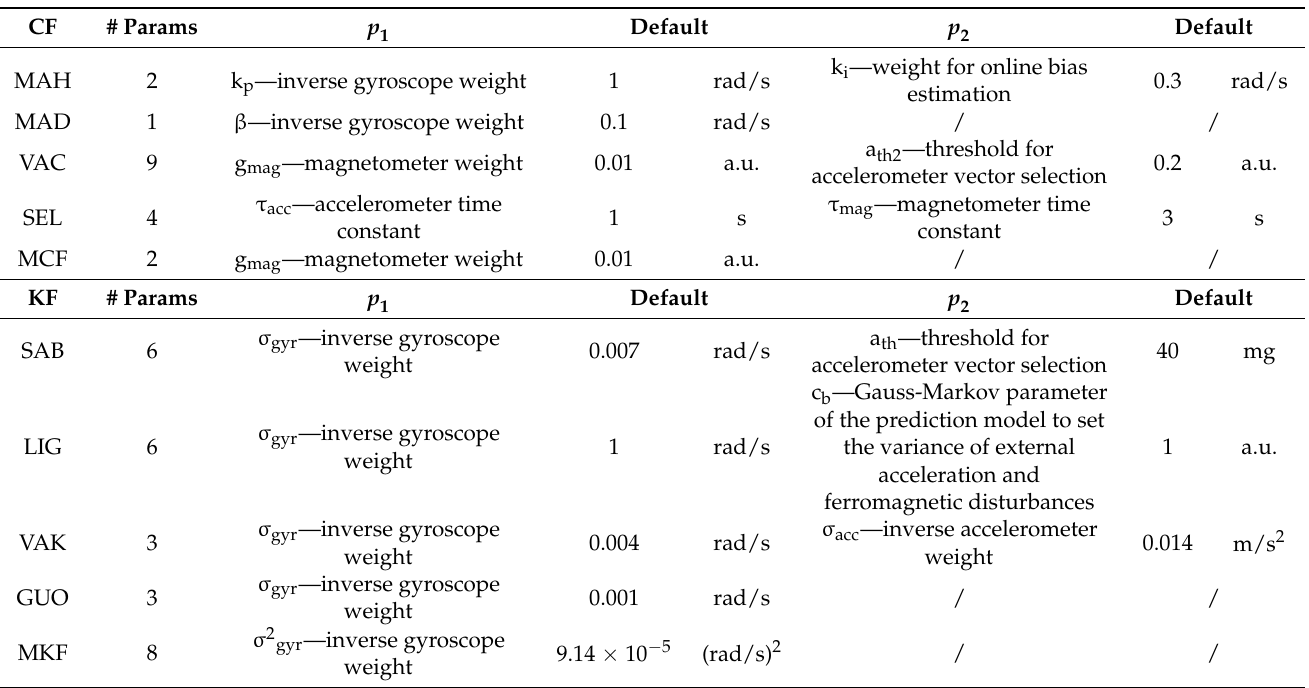
Table 1. Details of each Sensor Fusion Algorithm (SFA) considered. The # Params column reports the total number of parameters of each SFA. The p 1 and p 2 report the description of the parameter tuned to detect the optimal values. a.u. = arbitrary